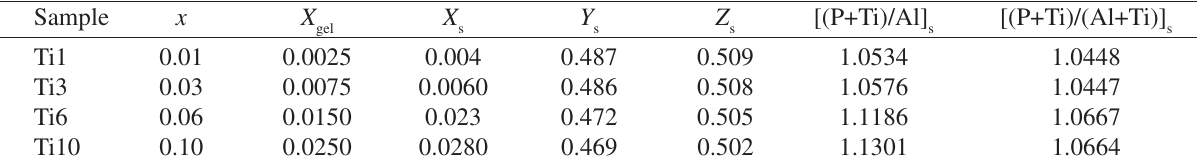
Table 1 . Chemical analysis of TAPO-5 containing different Ti contents synthesized with 46